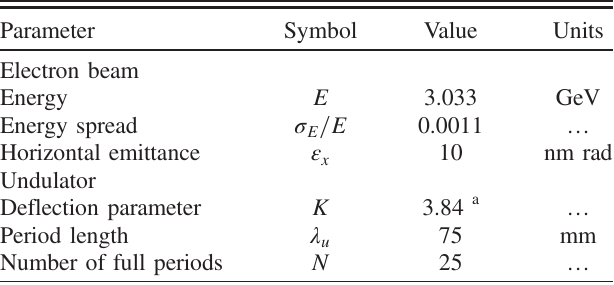
was used in simulations rather than an ideal sinusoidal field distribution